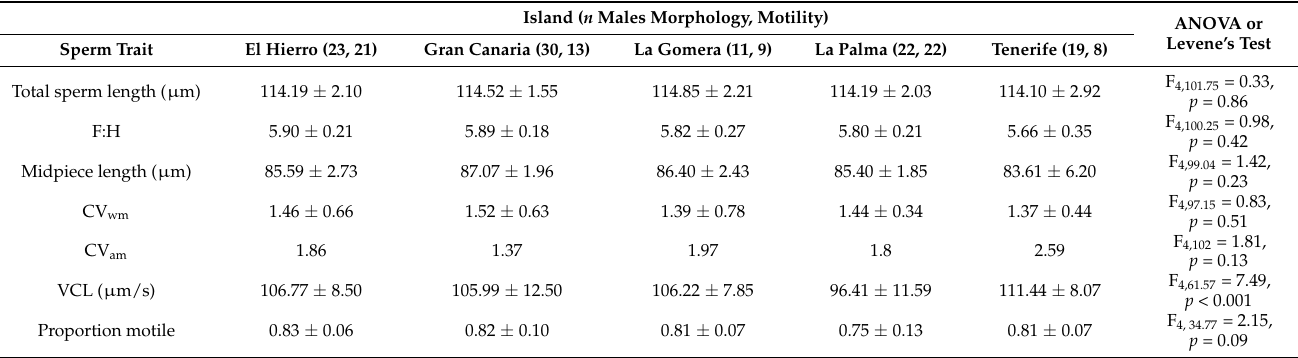
Table 1. Mean ± SD values and statistical comparisons for sperm morphological and motility measurements for the five Canary Islands. Island ( n Males Morphology,